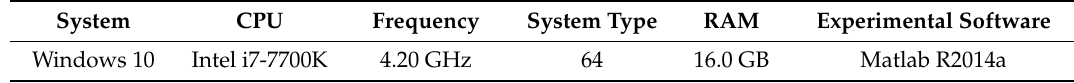
Table 1. Experimental environment.